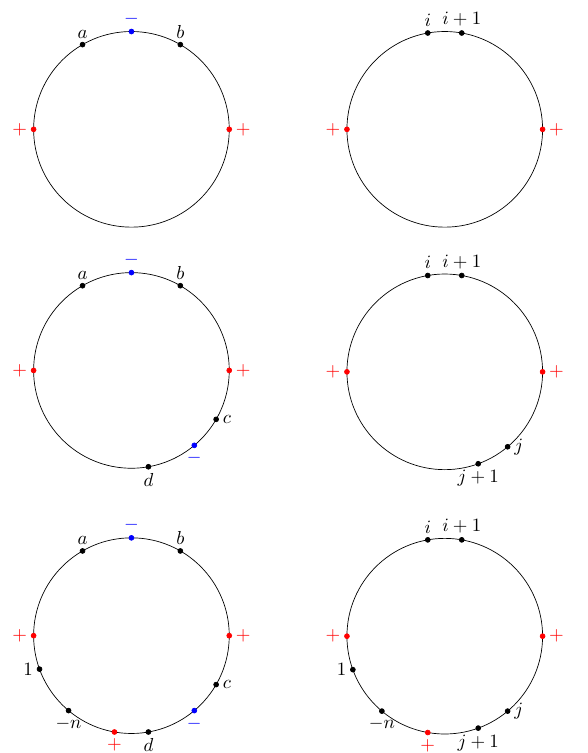
Figure 4 . Signs of brackets involving the point V i depend on its position relative to the other indices. In the top (cid:12)gure we see that for d = 2, the signs can be positive or negative depending on whether there is a gap between a; b . When there is no gap, the signs are always positive. The middle (cid:12)gure shows the same phenomenon for d = 4. The bottom (cid:12)gure shows the novelty for odd d , where V 1 and - V n must